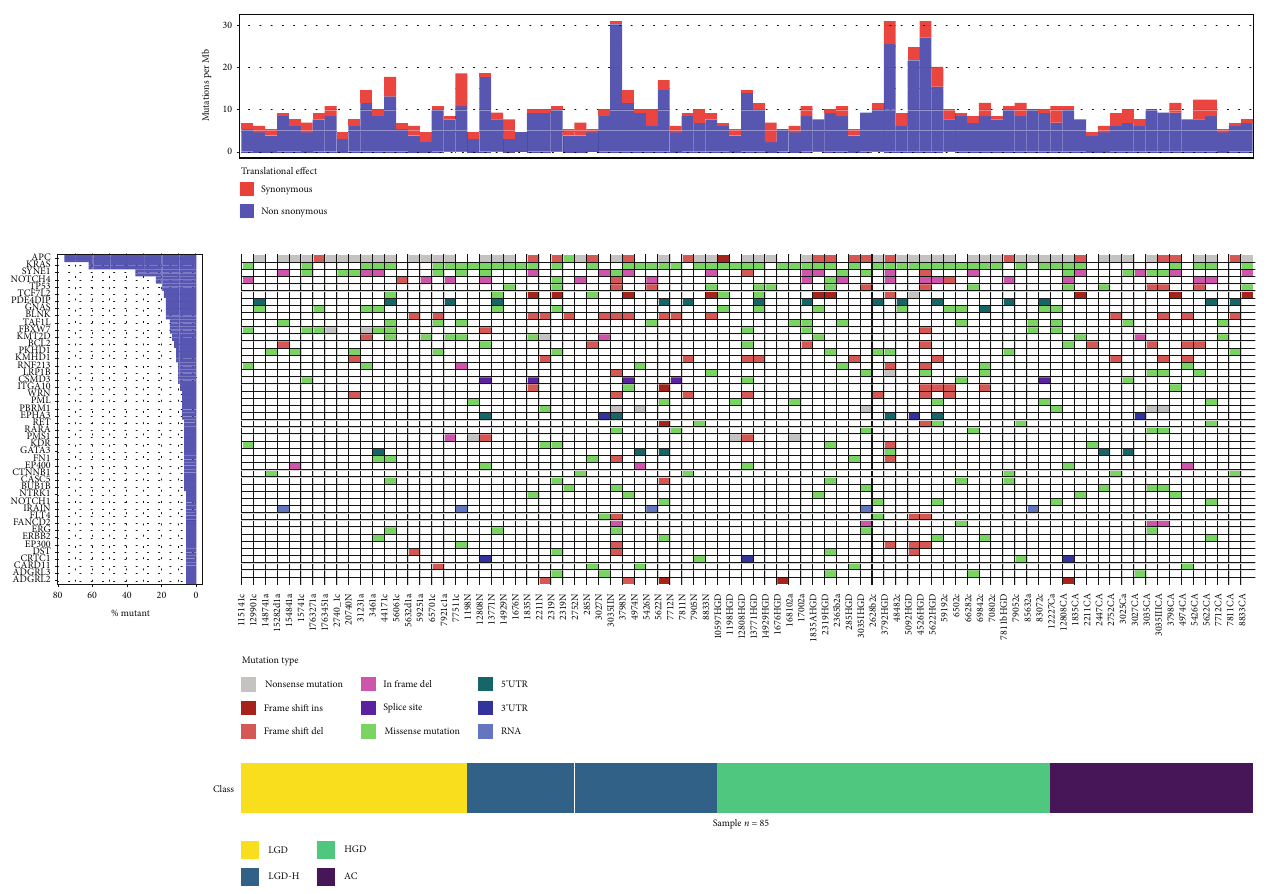
Figure 1: The structure of genetic variance among the investigated samples. Waterfall plot of genes mutated in > 5% of samples. Mutation frequency, shown in the top panel, is calculated relative to the assayed DNA length (1.29 Mb). LGD: low-grade dysplasia; HGD: high- grade dysplasia; LGD-H: low-grade dysplasia adjacent to areas of high-grade dysplasia and/or carcinoma; AC: